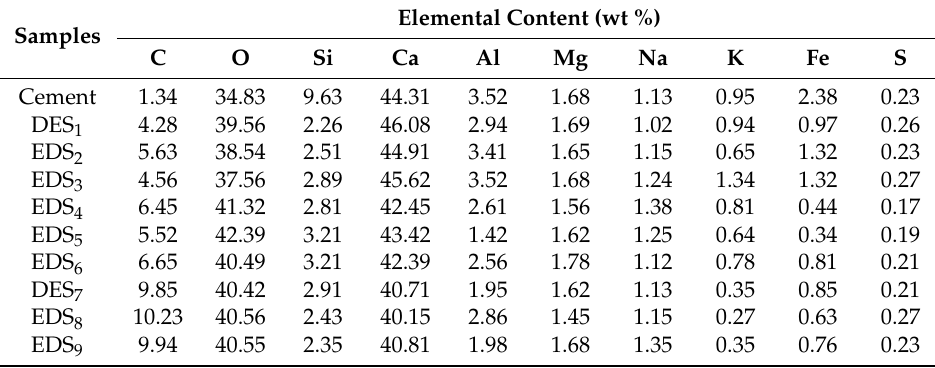
Table 3. Elemental composition of cement matrix doped with graphene oxide (GO). Elemental Content (wt Samples